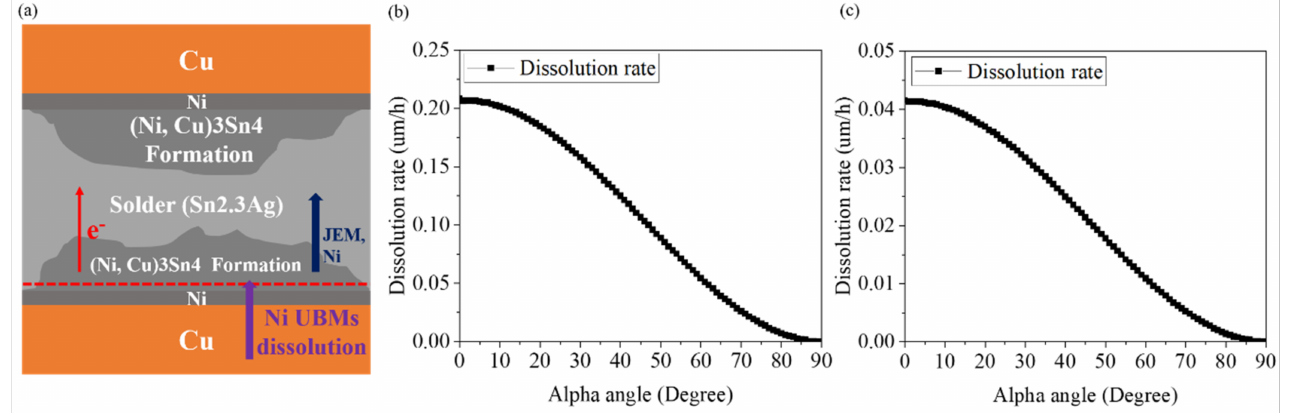
Figure 8. ( a ) Schematic diagram showing the atomic diffusion of Ni flow. The red dotted line represents the original position before the EM test. Relationship between the theoretical dissolution rate of Ni UBM and α -angle at ( b ) 8 × 10 4 A/cm 2 and ( c ) 1.6 × 10 4 A/cm 2 current